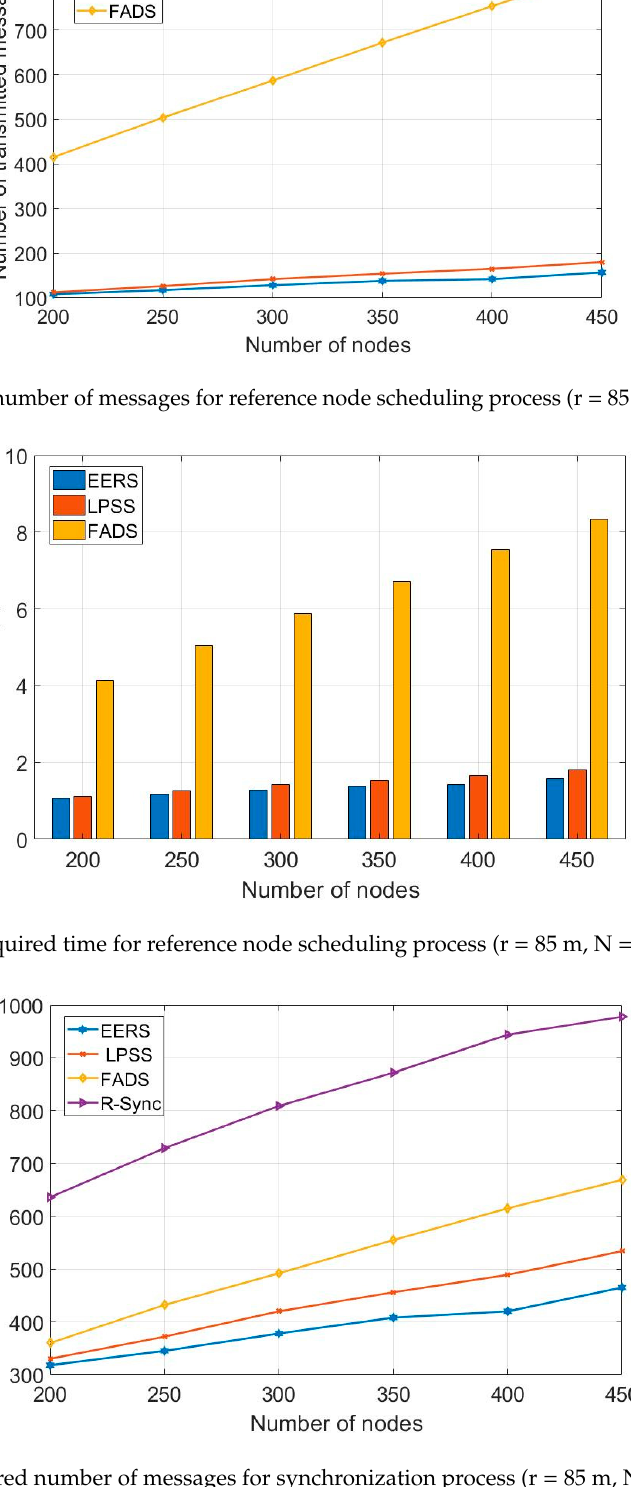
Figure 9. Required number of messages for synchronization process (r = 85 m, N = 200: 450).